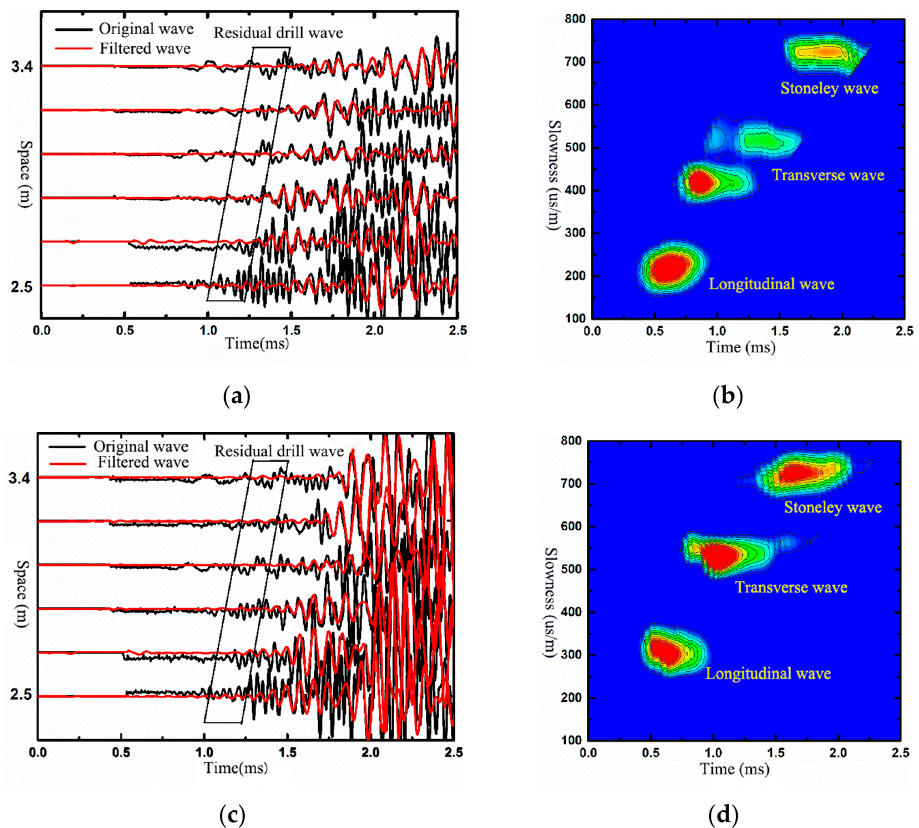
Figure 16. Waveforms and STC results of a depth point in anisotropic formation: ( a , b ) is in upper module well; ( c , d ) is in lower module well.